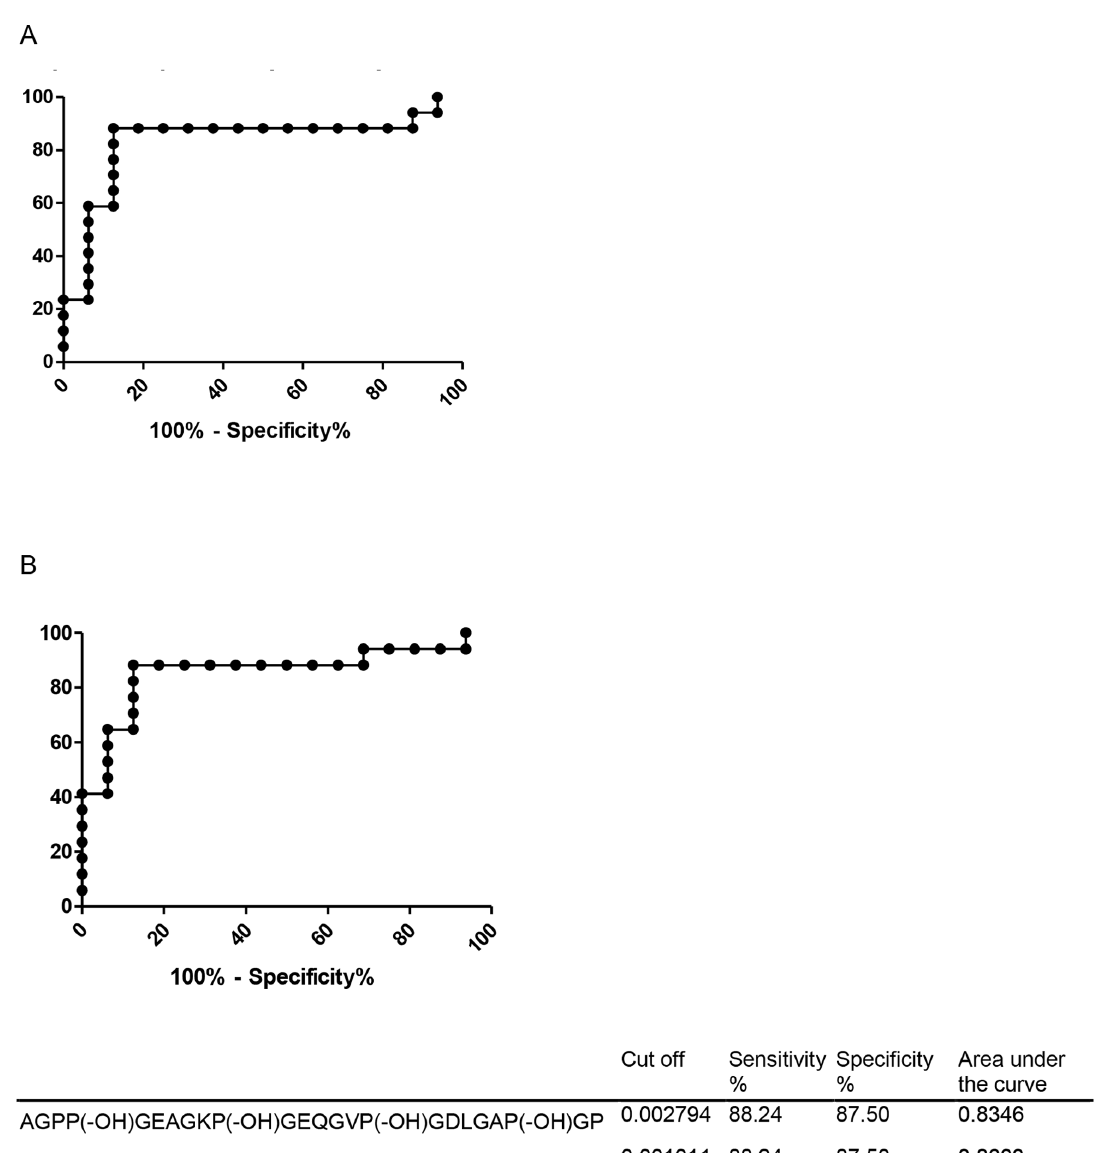
Figure 1. ROC-curves of the selected peptides AGPP(-OH)GEAGKP(-OH)GEQGVP(-OH)GDLGAP(-OH)GP and P(-OH)GNSGEP(-